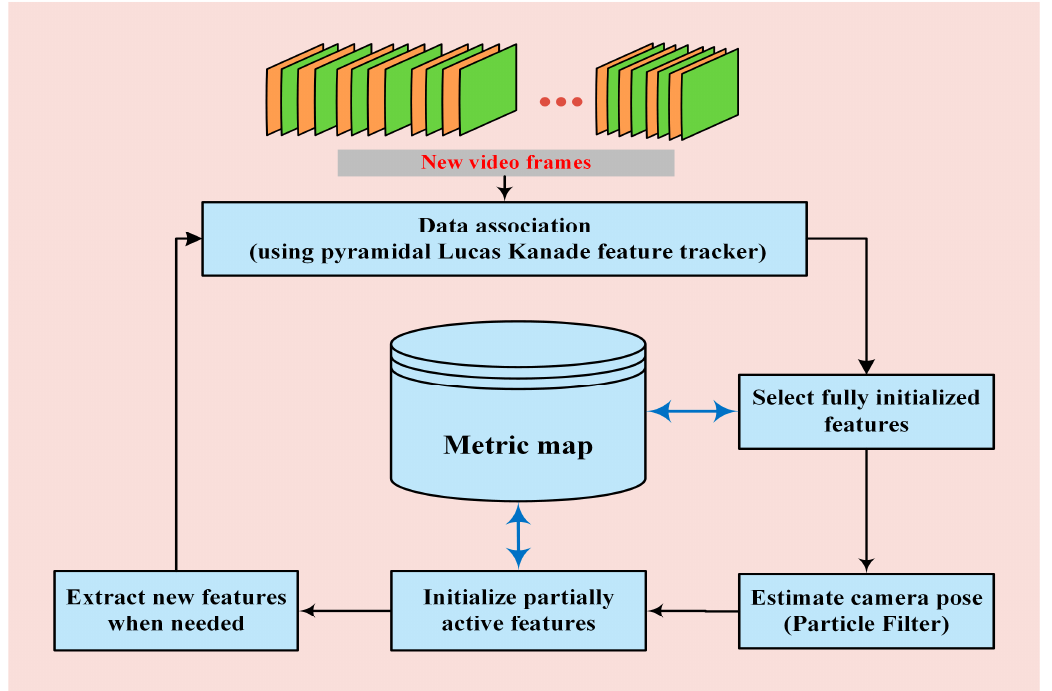
Figure 1. Overview of the proposed approach.